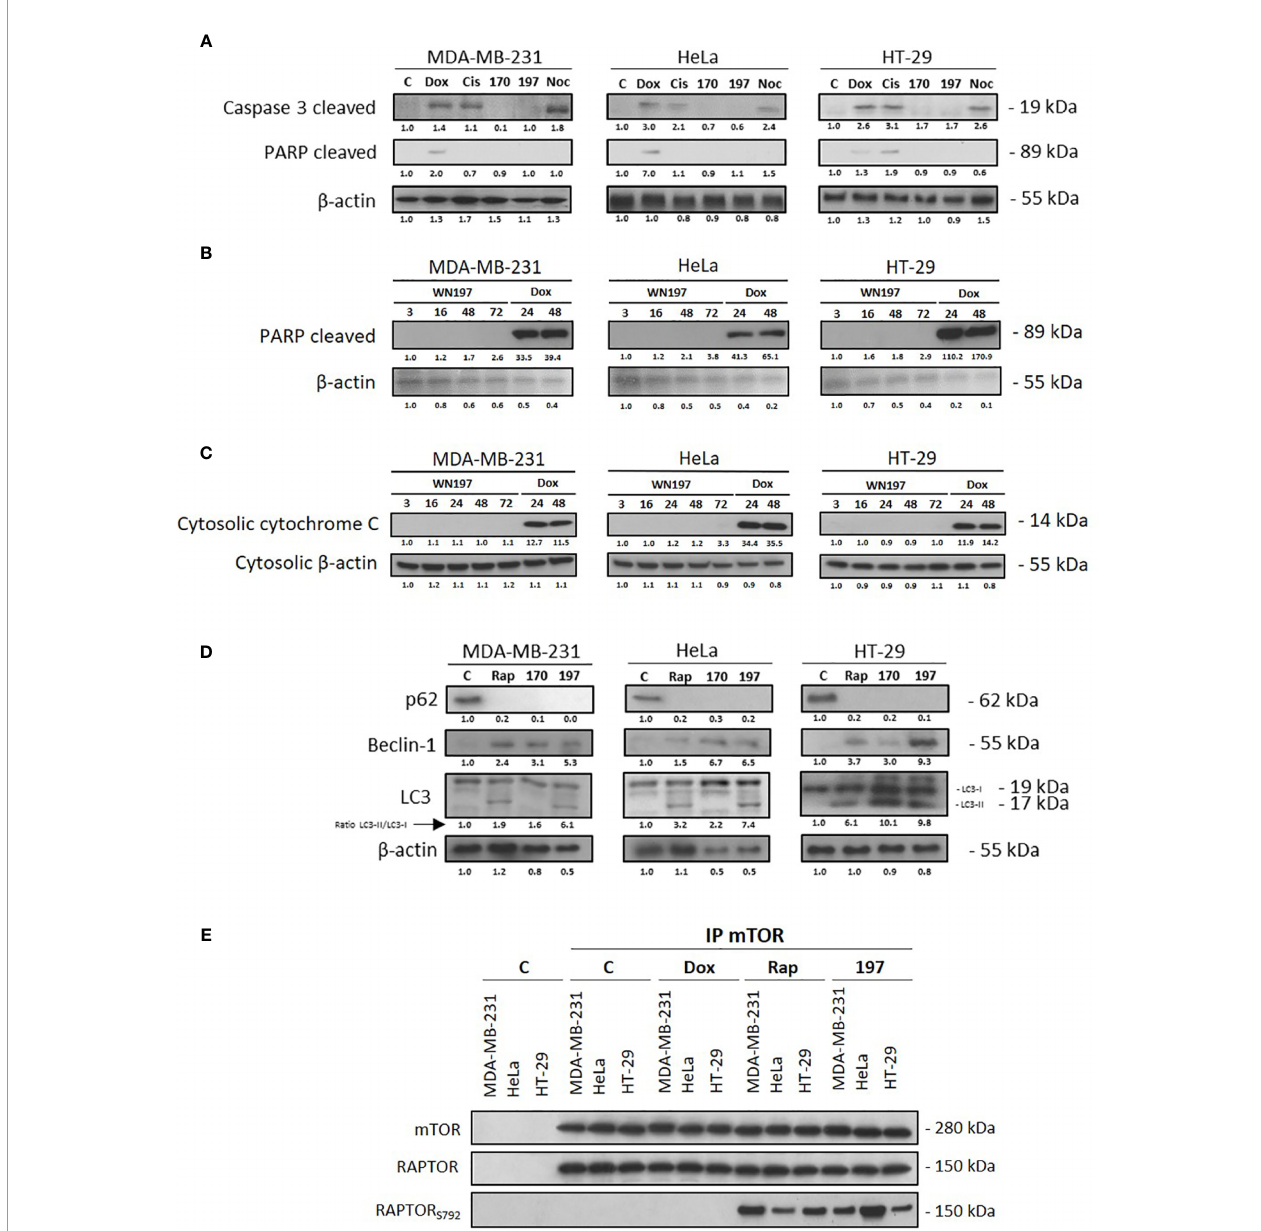
FIGURE 7 | WN197-induced autophagy. Cells were treated for 24 h with doxorubicin (5 µM), cisplatin (20 µM), WN170, WN197 (0.5 µM), nocodazole (84 nM) or rapamycin (0.5 µM). (A) Cleaved caspase 3 and PARP analysis by Western blots. Western blot analysis, after 3, 16, (24 or not), 48 and 72 h of treatment with WN197 or doxorubicin for 24 and 48 h, of (B) cleaved PARP or (C) cytosolic cytochrome (C, D) p62, Beclin-1, and LC3 markers analysis by Western blot. LC3 levels were expressed upon the LC3-II/LC3-I ratio. b -actin levels were used as a loading control. Relative protein levels were expressed by densitometry using Image J software (Fiji Software, v1.52i). (E) mTOR immunoprecipitations were realized in cell lines untreated or treated with doxorubicin (5 µM), rapamycin (0.5 µM) or WN197 (0.5 µM) for 24 h and followed by Western